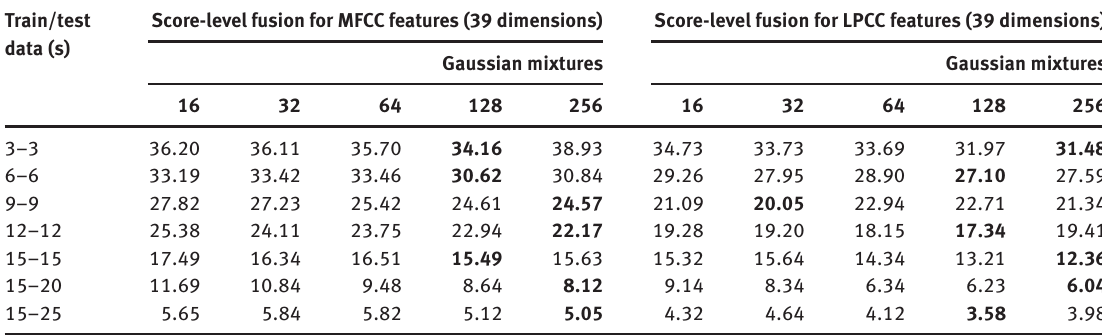
Table 11: Performance of the Speaker Verification System for Score-Level Fusion Using i-Vector and GMM–UBM Modeling Tech- niques for Limited Data Condition on the NIST 2003